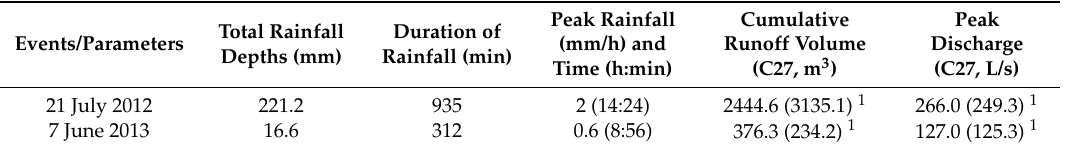
Table 1. Summary of rainfall characteristics and hydrographs for two rainfall events for model calibration and